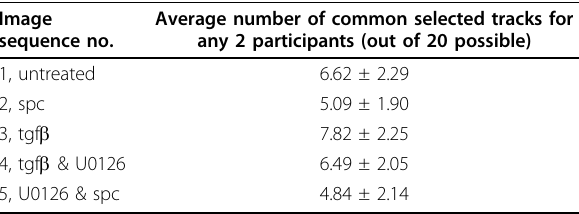
Table 2 Levels of agreement between any two participants in selecting “ representative ” subsets of 20 cells from cell populations Image sequence